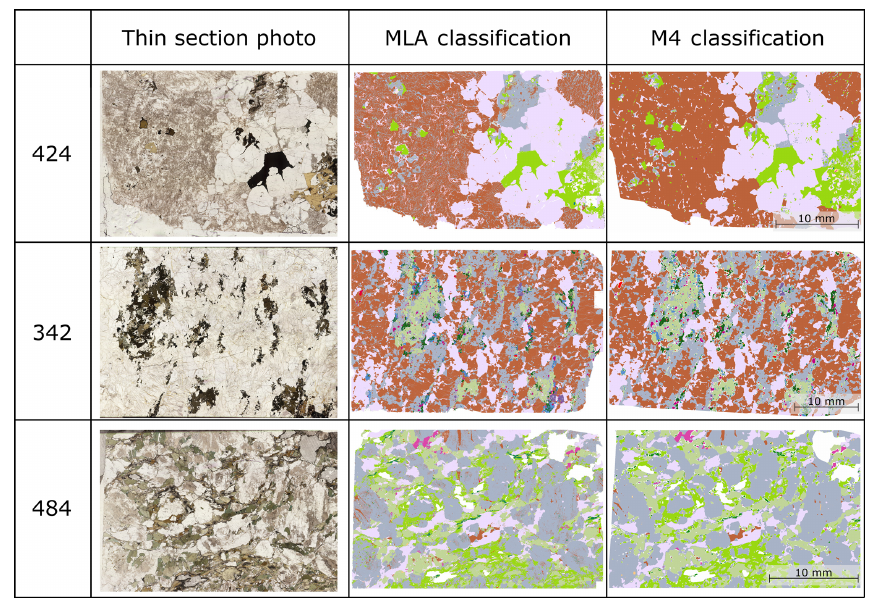
Figure 3. Thin section scan and classification results from mineral liberation analyzer (MLA) and M4 Tornado – ENVI. The size of thin sections 424 and 484 is about 30 × 20mm; thin section 342 is about 40 × 25mm; the color key for the classified minerals is displayed